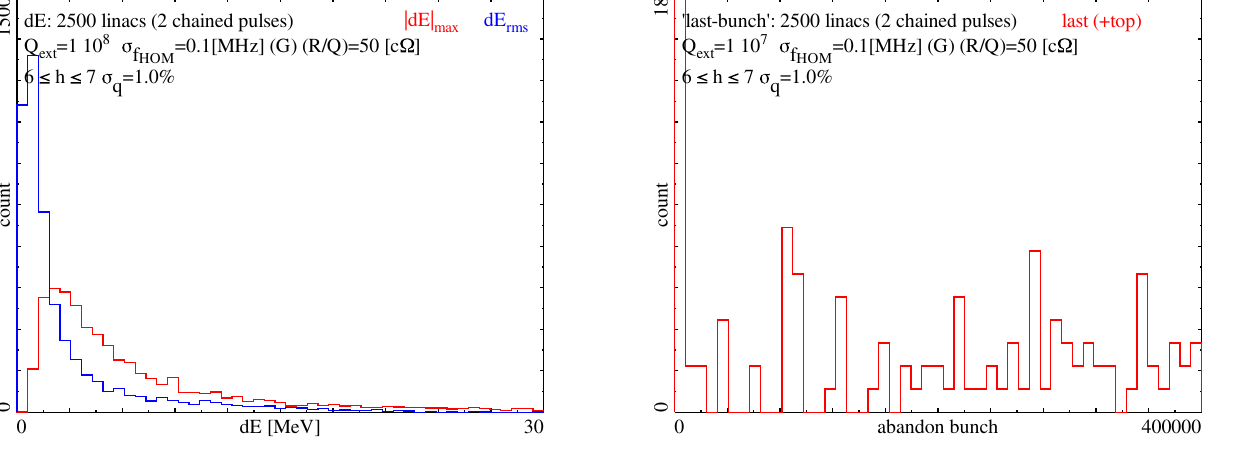
FIG. 19. (Color) Histogram of dE [0–30 MeV, 50 bins] for ¼ 10 8 , worst: red; rms: blue; 2500 different HOM setups; Q ext conditions as in Fig. 8.